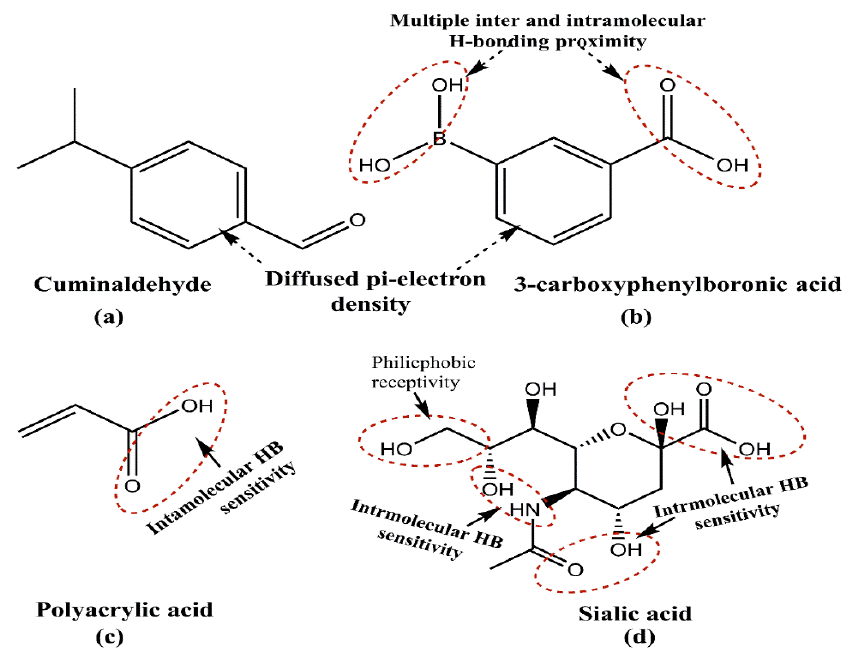
Figure 14. Chemical structures of ( a ) cuminaldehyde, ( b ) 3-carboxyphenylboronic acid (PBA), ( c ) polyacrylic acid (PAA) and ( d ) sialic acid. While cuminaldehyde and PBA are endowed with pi-electron densities favoring an electrophile attack, the pulsating hydrogen bonding susceptibilities in PBA, PAA and sialic acid receptors imply that non-covalent interactions provide a higher suitability for sustained drug release through nanocarriers.